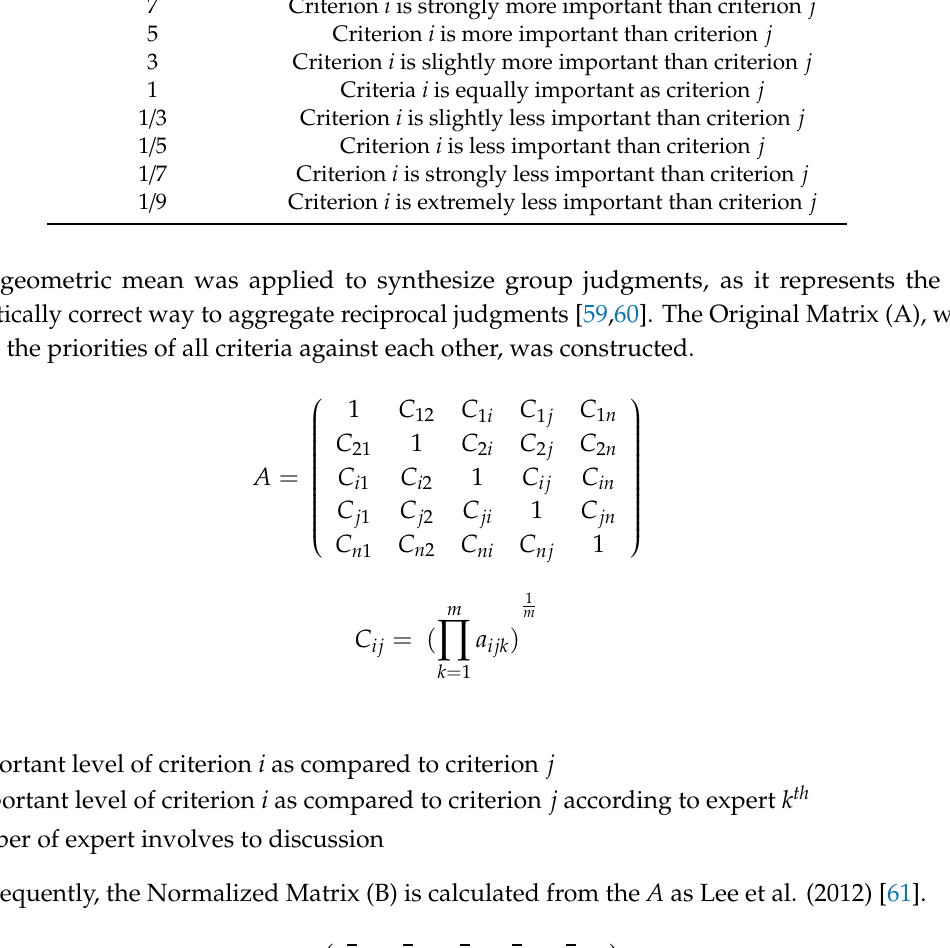
Criterion i is slightly more important than criterion j Criteria i is equally important as criterion j Criterion i is slightly less important than criterion